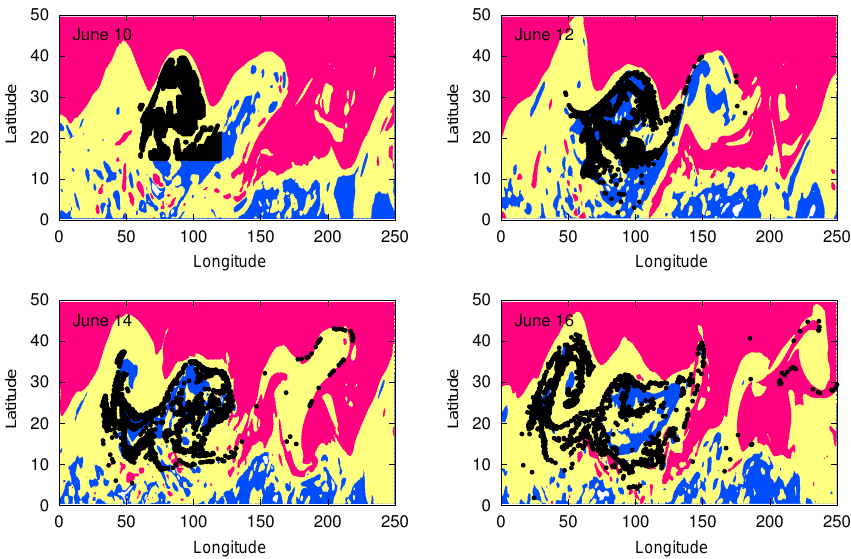
Figure 2. Example of isentropic trajectories on 360K, released on 10 June. Black dots highlight trajectory locations on 10, 12, 14 and 16 June, together with PV (red: > 2PVU; blue: < 0.3PVU; yellow: